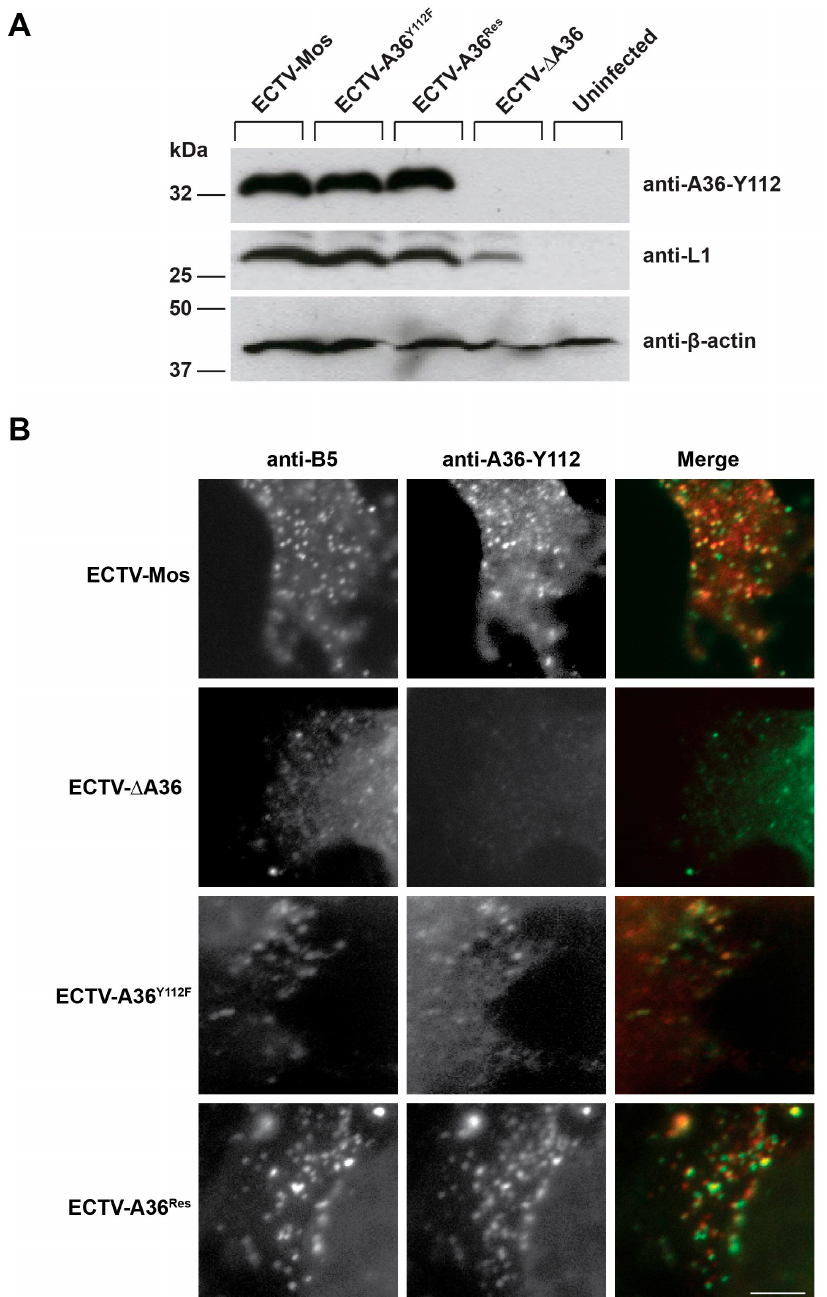
Figure 2. ECTV-A36 Res has normal A36 expression and localization. ( A ) BSC-1 cells were infected at a multiplicity of infection (MOI) of 1, and cell lysates were collected at 48 hours post infections (hpi). Cell lysates were separated by sodium dodecyl sulfate-polyacrylamide gel electrophoresis (SDS-PAGE) and transferred to nitrocellulose membranes for immunoblotting with anti-A36-Y112, anti-L1 and anti- β -actin. Molecular size markers are indicated on the left. ( B ) HeLa cells were infected with the indicated viruses and fixed at 24 hpi and probed with anti-B5 (green) and anti-A36-Y112 (red) and visualized by immunofluorescence microscopy. Scale bar: 5 μ m.